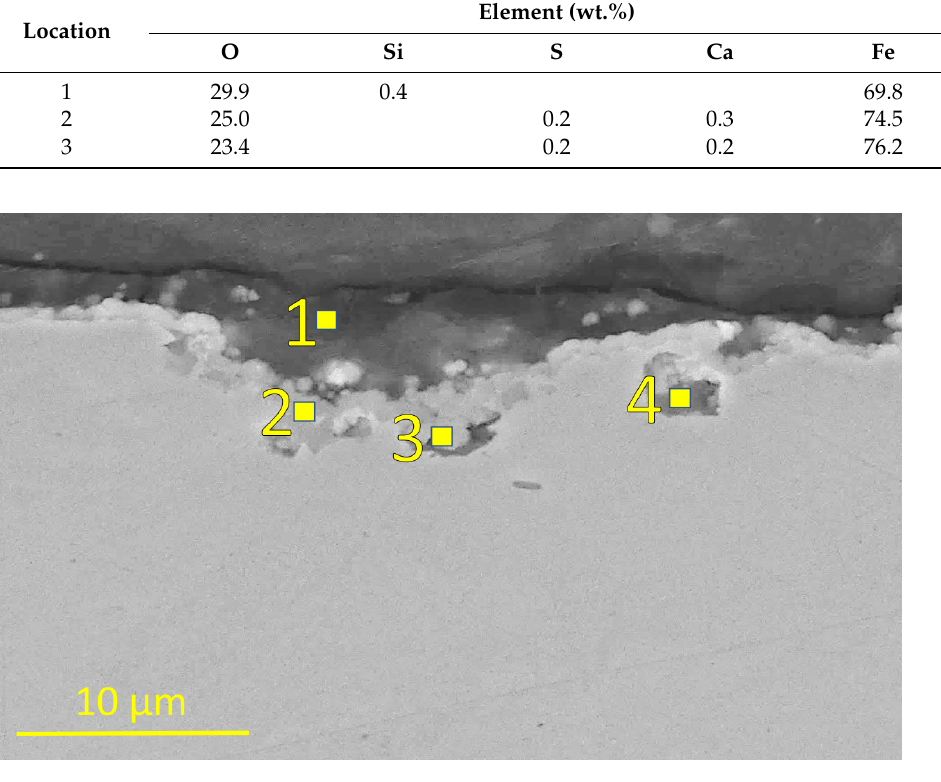
Figure 10. Cross-section in the centre of the tested carbon-steel sample 8 in the middle of the last reactor (condenser). reactor Table 10. Elemental analysis from locations in Figure 10.